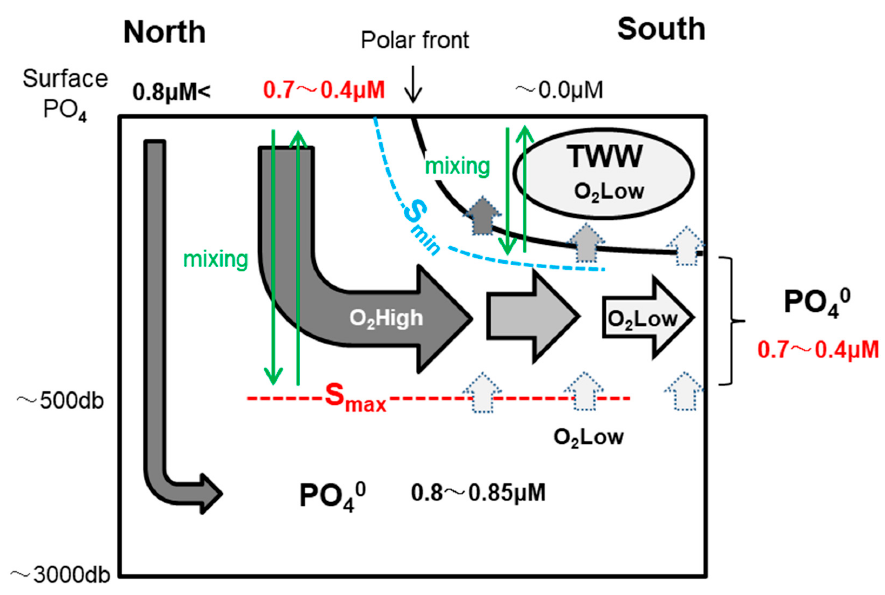
Figure 11. Schematic diagram for the behavior of the water mass beneath the TWC.